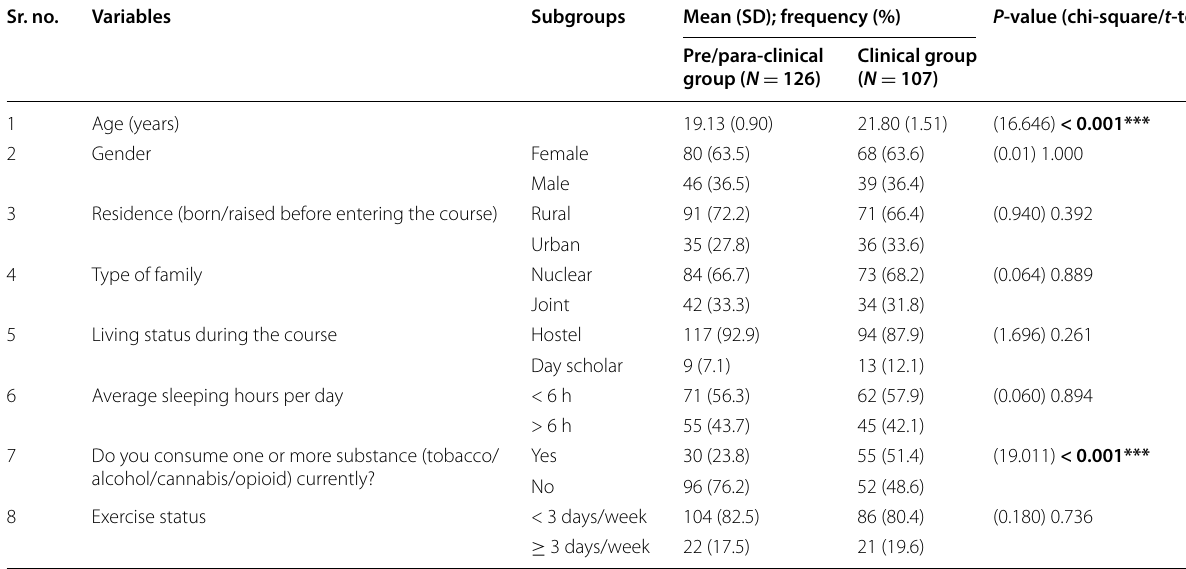
Table 5 Comparison of association of sociodemographic variables between pre/para-clinical and clinical students with psychological